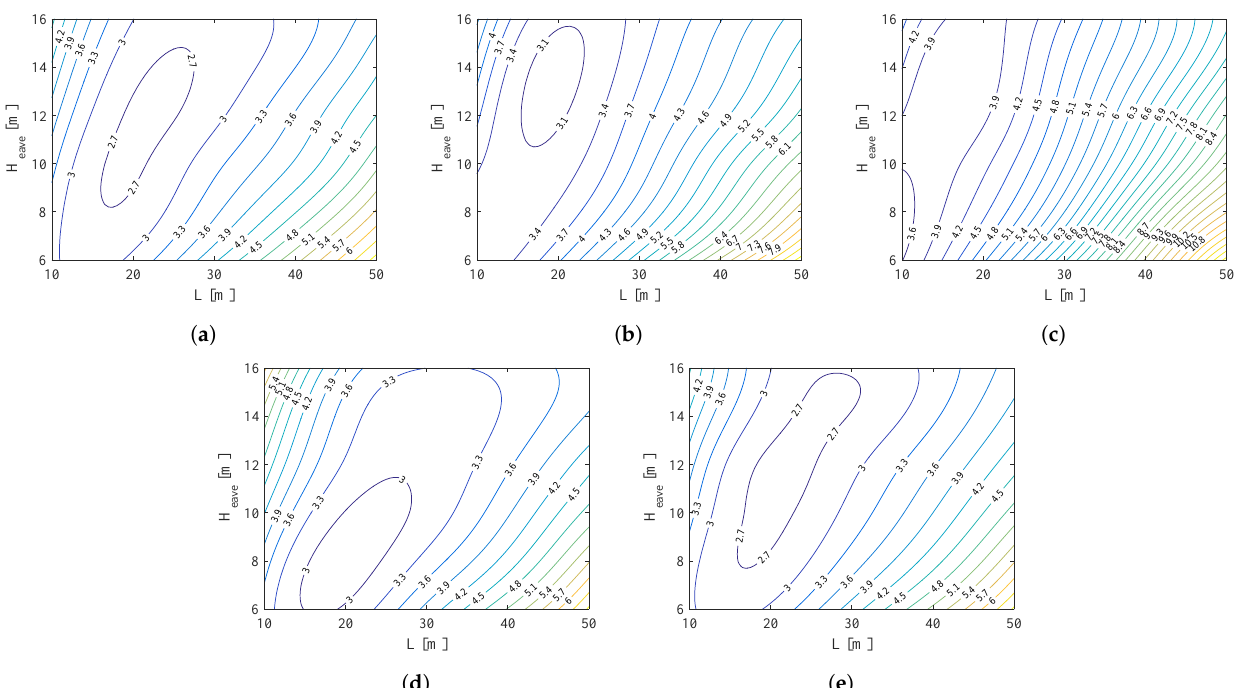
Figure A3. Contours of optimal frame ECI (kgCO 2 /m 3 ) for Model 2: ( a ) Detroit, MI; ( b ) St. Paul, MN; ( c ) Berlin, NH; ( d ) Miami, FL; ( e ) St. Charles, KY.